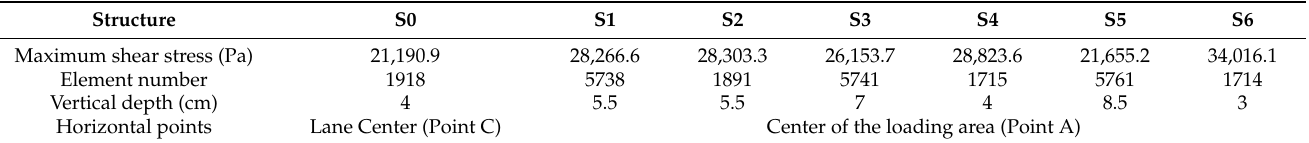
Figure 10. Shear stress in the asphalt layer: ( a ) Time–history curve; ( b ) maximum shear stress. Table 7. Maximum values and locations of shear stress in the asphalt layer.